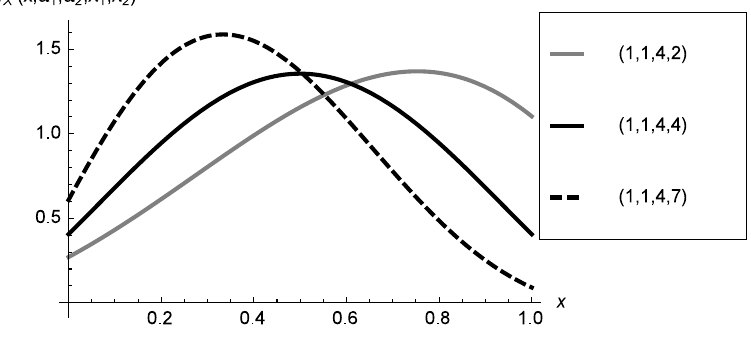
Figure 6 { Plots of the density of X ′ (cid:24) DNCB ( (cid:11) 1 ; (cid:11) 2 ; (cid:21) 1 ; (cid:21) 2 ) for (cid:11) 1 = (cid:11) 2 = 1 and selected values of (cid:21) 1 ; (cid:21) 2